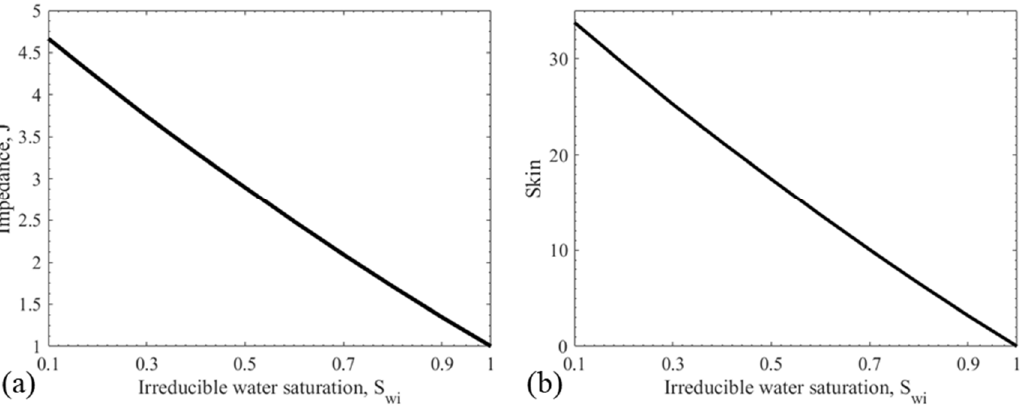
connate water saturation.